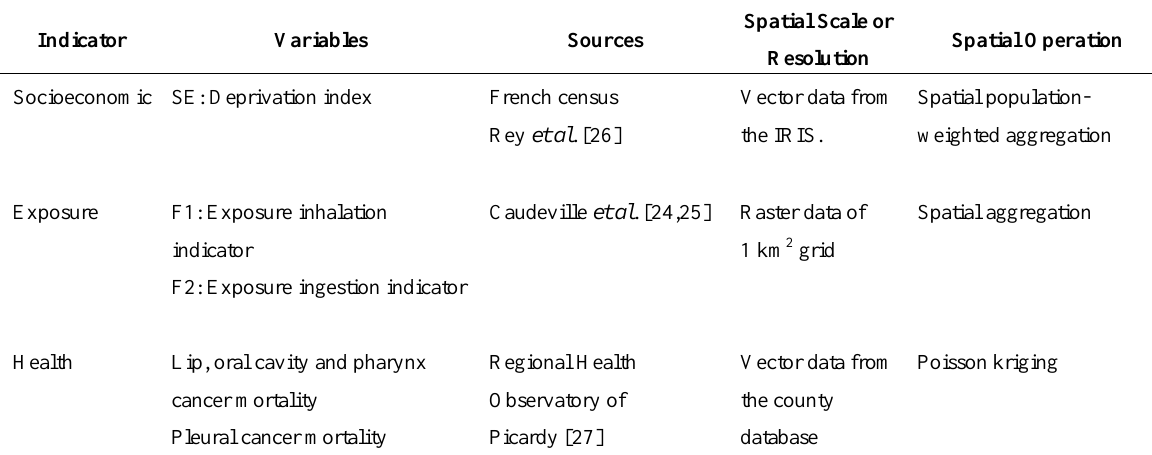
Table 2. Spatially resolved data types and approaches used to homogenize spatial